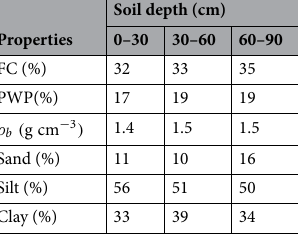
Table 1. Physical properties of the soil at the experimental site 87